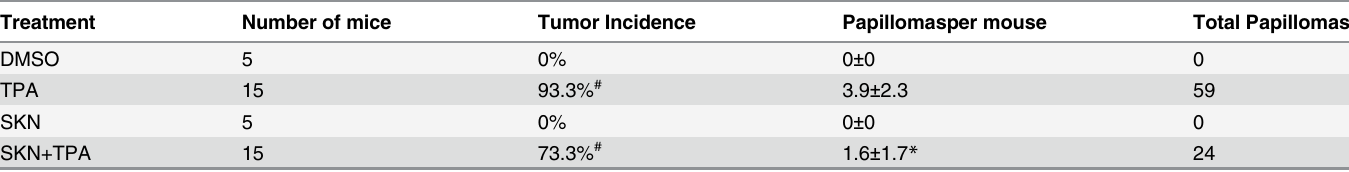
Table 1. Papilloma formation in the multistage carcinogenesis model. Treatment Number of mice Tumor Incidence Papillomasper mouse Total